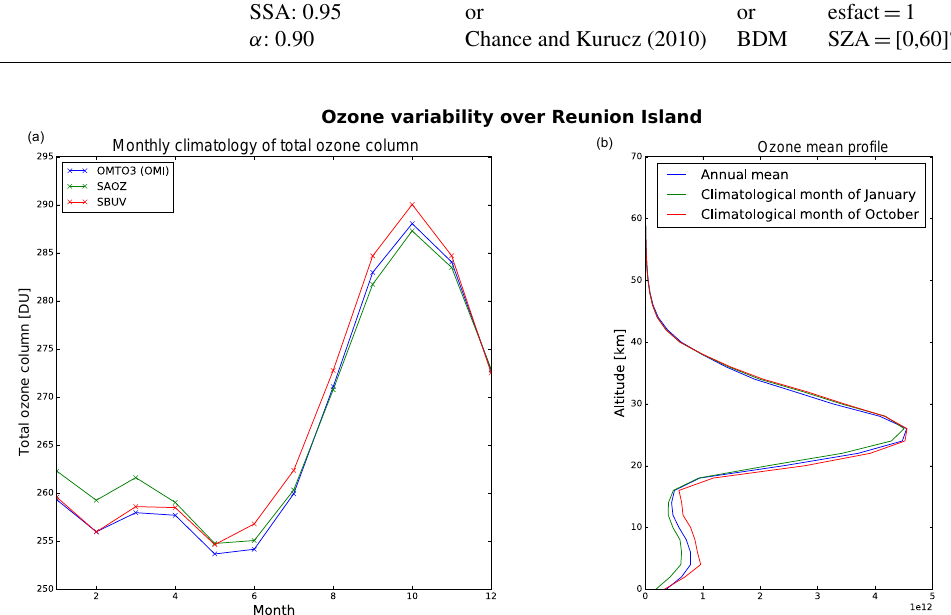
Figure 3. Ozone variability over Reunion Island. (a) Monthly climatology of total ozone column for three data sets (OMI in blue, SAOZ in green and SBUV in red). (b) Mean ozone profile from McPeters and Labow (2012) climatology. Annual mean in blue, January in green and October in